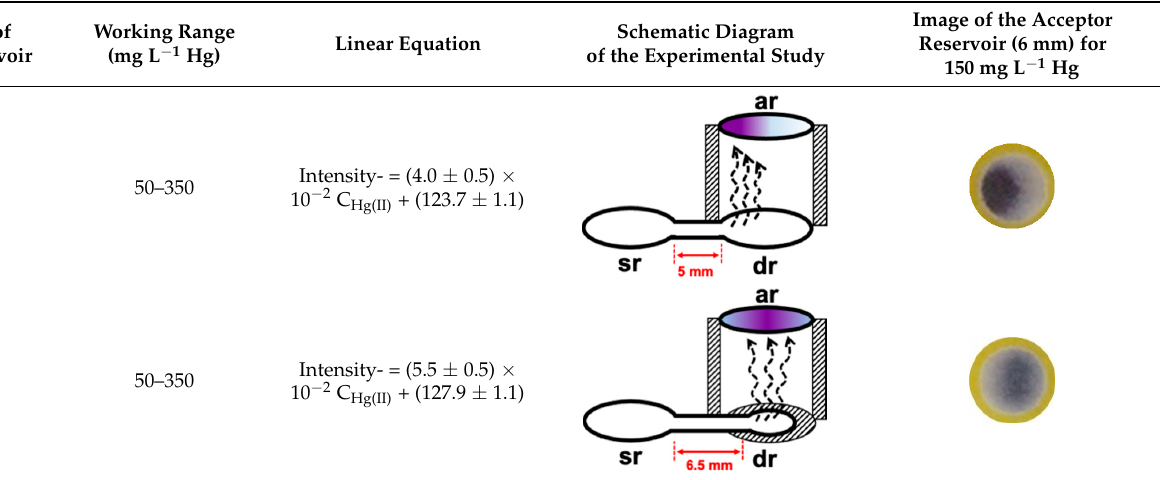
Molecules 2021 , 26 , x FOR PEER REVIEW Table 1. Effect of size of diameter of donor reservoir on homogeneity of color distribution at the acceptor reservoir and on the sensitivity of analysis. Table 1. Effect of size of diameter of donor reservoir on homogeneity of color distribution at the acceptor reservoir and on Table 1. Effect of size of diameter of donor reservoir on homogeneity of color distribution at the acceptor reservoir and on the sensitivity of analysis. Table 1. Effect of size of diameter of donor reservoir on homogeneity of color distribution at the acceptor reservoir and on the sensitivity of analysis. Table 1. Effect of size of diameter of donor reservoir on homogeneity of color distribution at the acceptor reservoir and on the sensitivity of analysis. the sensitivity of analysis.